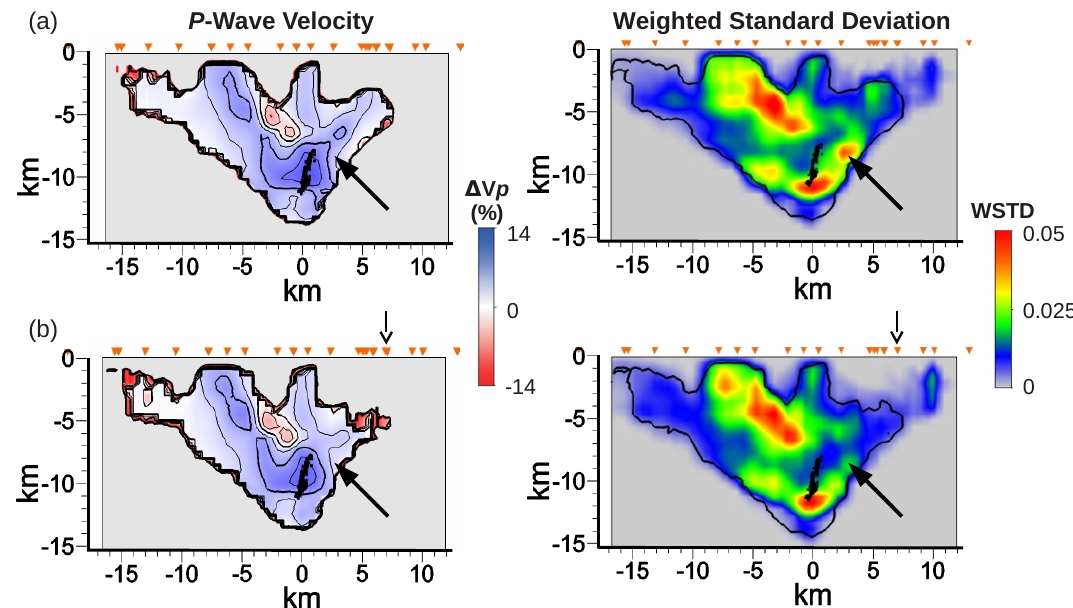
Figure 2. P -wave weighted average model (WAM) and weighted standard deviation (WSTD) for profile A-A 0 for (a) all stations and (b) selected stations. Bold arrow indicates the region of high WSTD present when all stations are used, and suppressed when the problematic station (indicated in b ) is removed from the data set. Only areas constrained by the data are shown. P -wave velocities are shown as percentage difference from the regional model of Málek et al.